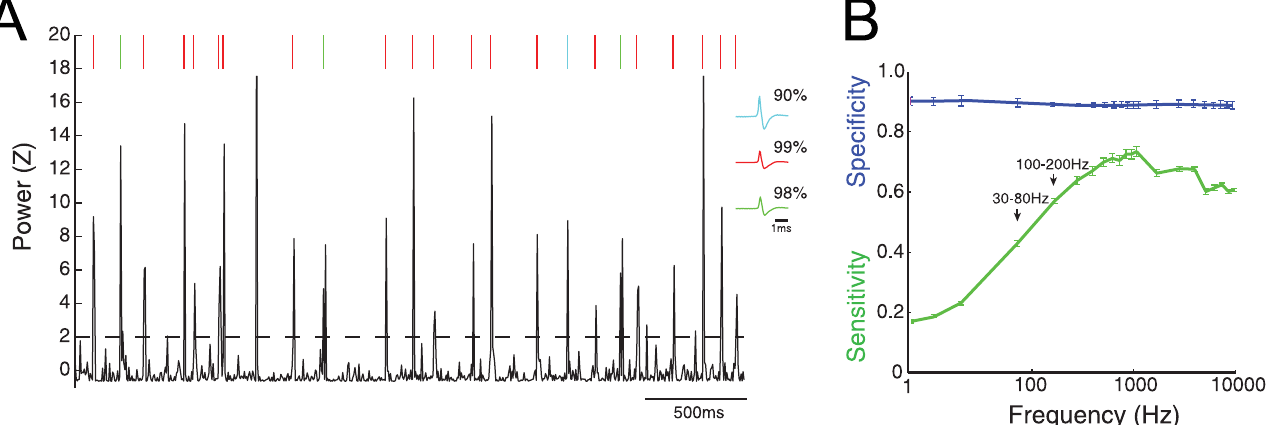
Fig 2. High frequency power can reliably detect spikes. A) 5s trace of power in 300-400Hz. Raster plots represent spikes whose color matches the waveform on left. Using a detection threshold (z > 2, dotted line), the sensitivity for three spikes on left was calculated. These percentages are shown next to their spike waveform. B) Sensitivity and specificity as a function of frequency for all cells, MSNs, and FSIs. Error bars denote SE. Time scale = 1